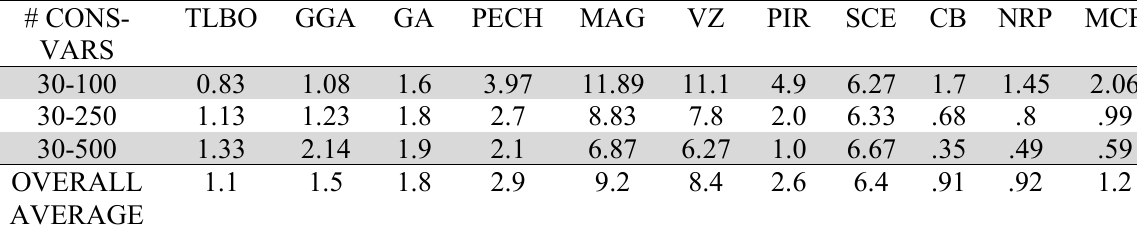
Deviation from optimum for 30 constraint problem